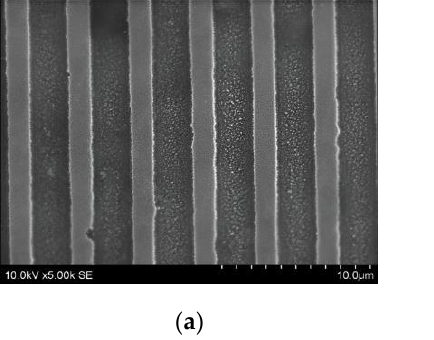
Figure 2. ( a ) SEM image of the master matrices. ( b ) Tensile testing experimental equipment: 1 — a computer that controls the test machine, 2 — temperature controller, 3 — cathode element, 4 — sample.